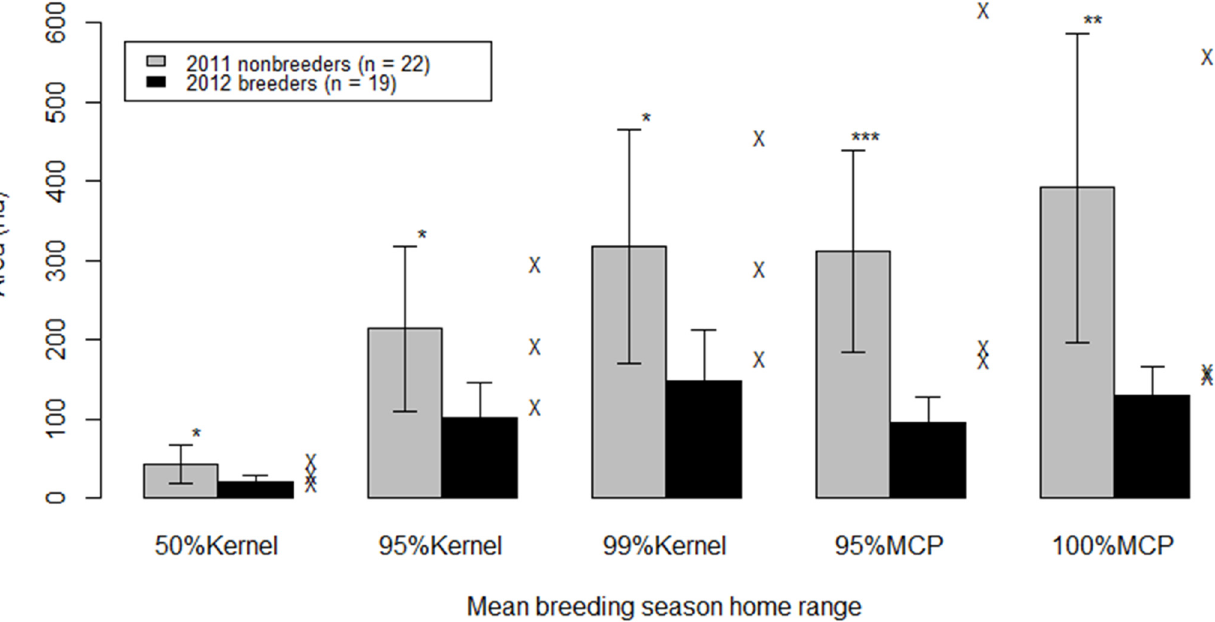
Fig 2. Estimated breeding season home range size. Estimated home range size of 2011 nonbreeders was significantly larger than range size of 2012 breeders. The estimated home range size for the three 2012 nonbreeders are included as X ’ s on the graph, but due to low sample size, were not included in analyses.